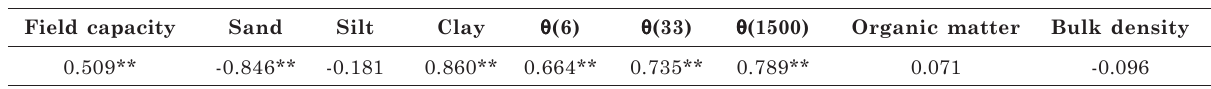
Table 1. Pearson correlation coefficients between the ring field capacity and basic soil properties, including FC (n= 56)